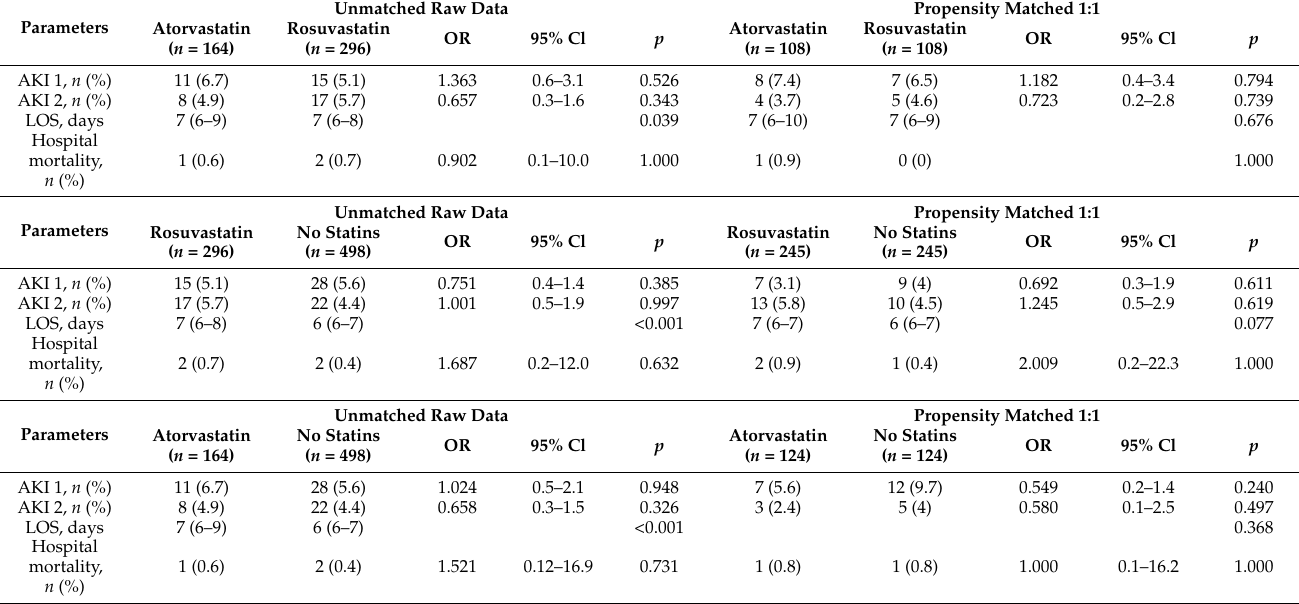
Table 2. Clinical data and operative